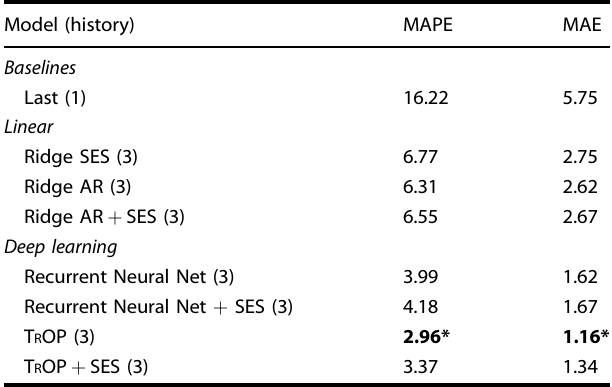
Table 2. Evaluation of T R OP and alternative methods with the inclusion of socio-economic variables.